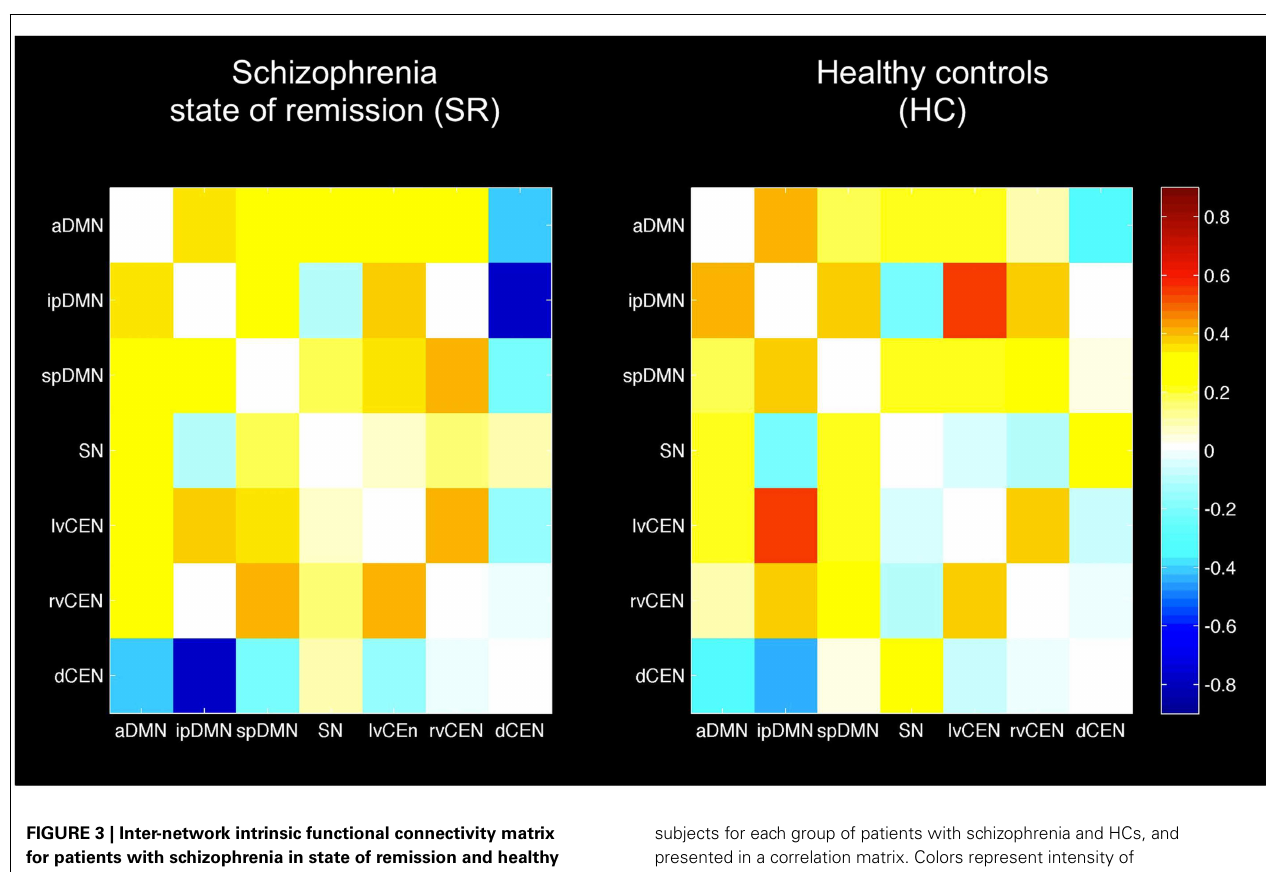
FIGURE 3 | Inter-network intrinsic functional connectivity matrix for patients with schizophrenia in state of remission and healthy controls (HCs) . Pairwise Pearson’s correlations between time courses of the default mode, salience, and central executive network (DMN, SN, CEN) were Fisher-z-transformed, averaged across